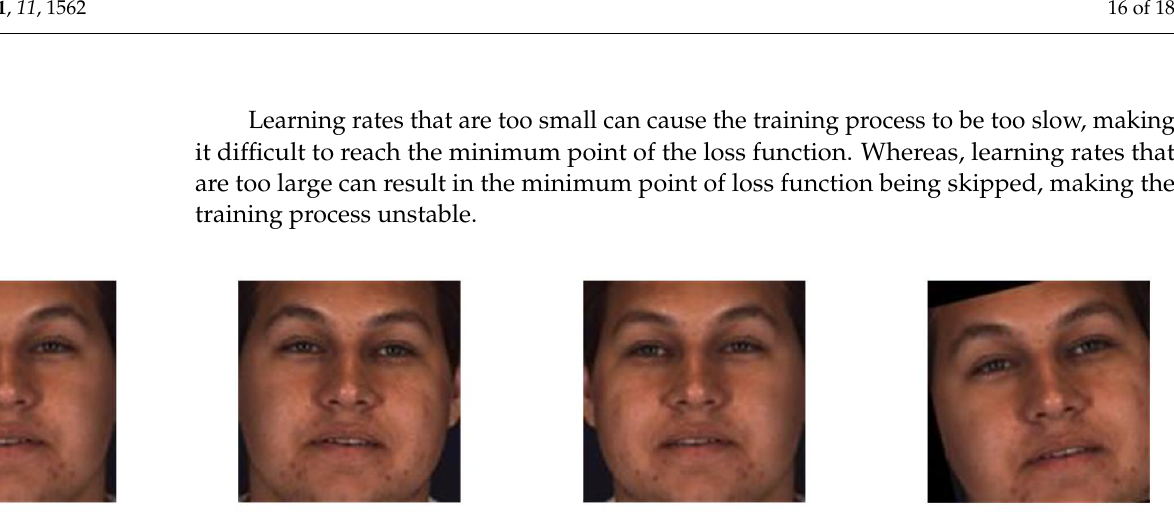
Figure A7. The image augmentation operation on the test dataset. Table A1. Results of 10 experiments of CNN model on the test dataset. Figure B7. The image augmentation operation on the test dataset. Table B1. Results of 10 experiments of CNN model on the test dataset.